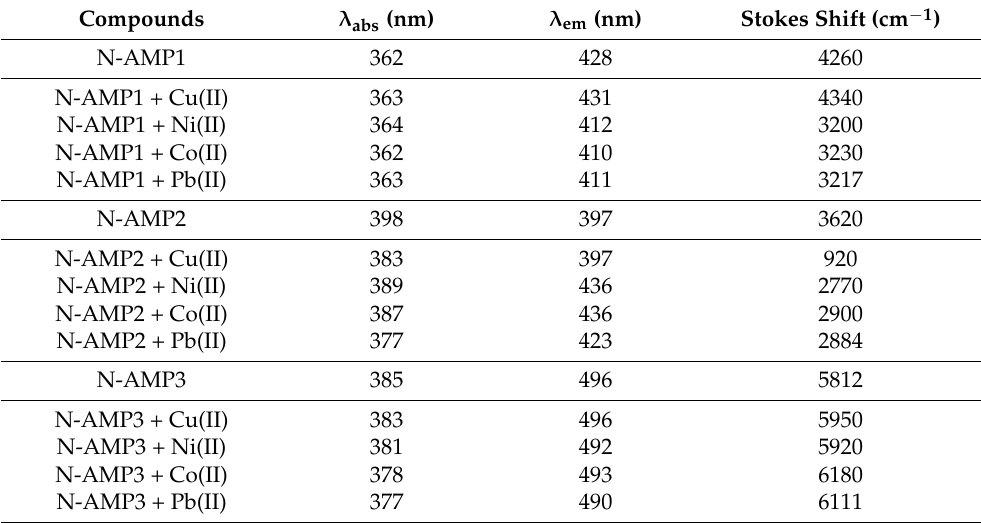
Figure 5. UV–Vis (zero) and first derivatives (inserted graphics) spectrum of complex equilibrium studies of the metals (Cu(II), Co(II), Pb(II), Ni(II)) with azo-azomethine derivatives: ( A ) N-AMP 1 (C = 4.88 × 10 − 5 mol L − 1 ); ( B ) N-AMP2 (C = 4.88 × 10 − 5 mol L − 1 ) and ( C ) N-AMP3 (C = 5.21 × 10 − 5 mol L − 1 ) at approximately equal concentrations of the metals and ligand. Table 2. Experimental determined Stokes shift of the dyes and their metal complexes (Cu(II), Ni(II), Co(II),